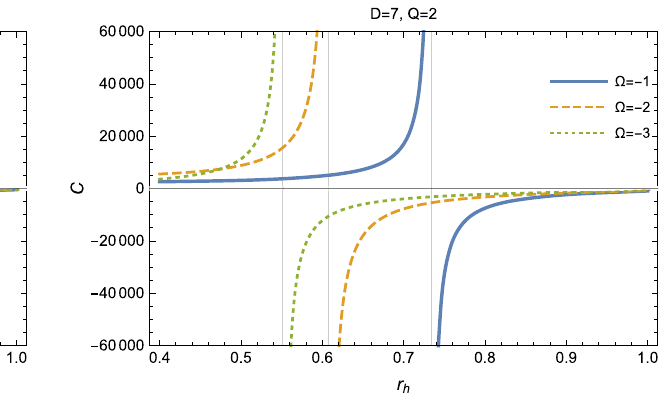
Fig. 1 he plots show how the heat capacity behaves for different val- ues of ω q . We have chosen the parameters as κ = 1, D = 7, ˜ α 0 = − 1 and ˜ α 1 = ˜ α 2 = ˜ α 3 = 1. Here we used the parameters for q and ω q ,